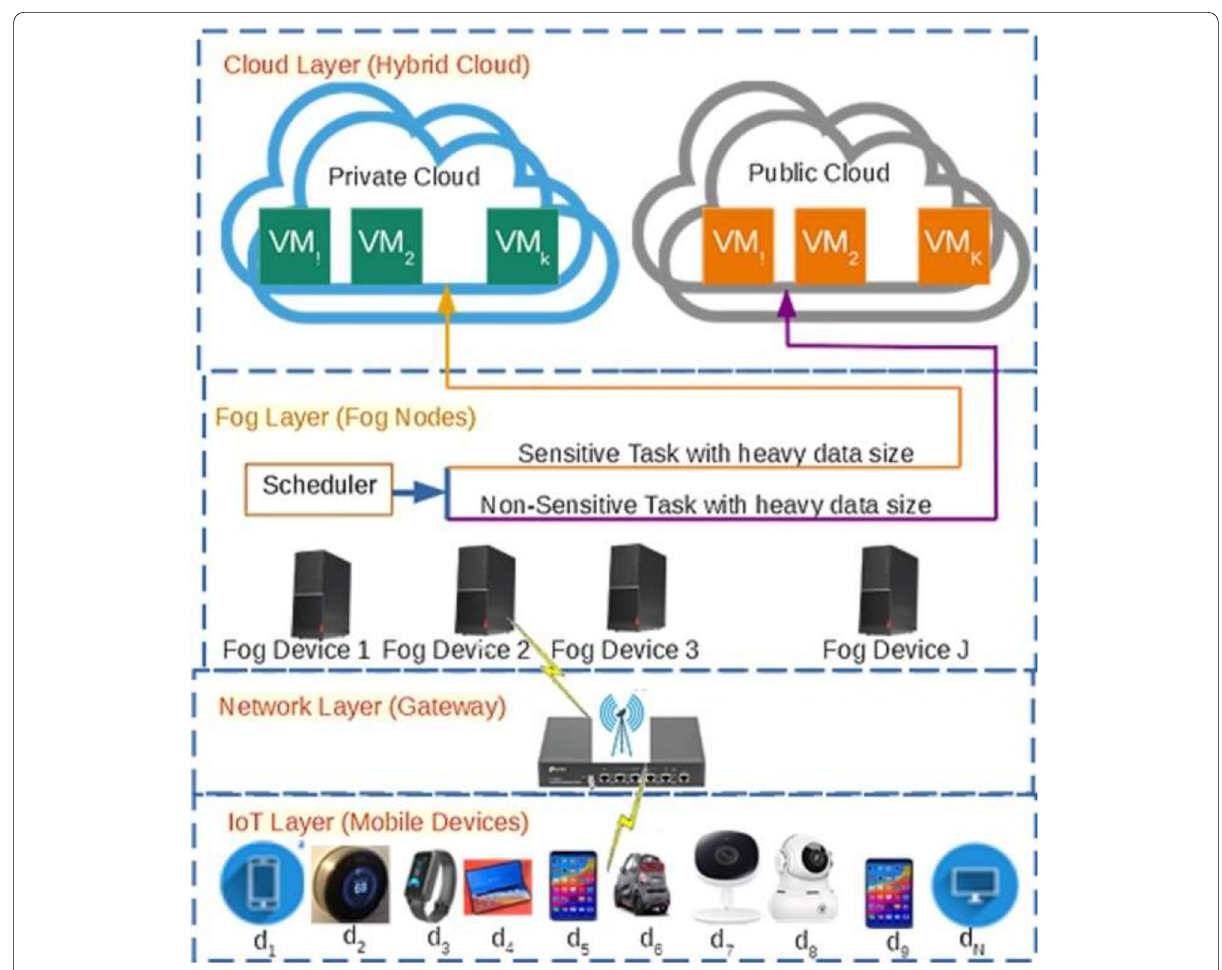
Fig. 1 System Model (d represents devices from I to N, Fog devices range from 1 to J, and cloud virtual machines (VM) range from 1 to K). N is the number of Mobile devices, J is the number of Fog devices and K is the number of virtual machines in the cloud